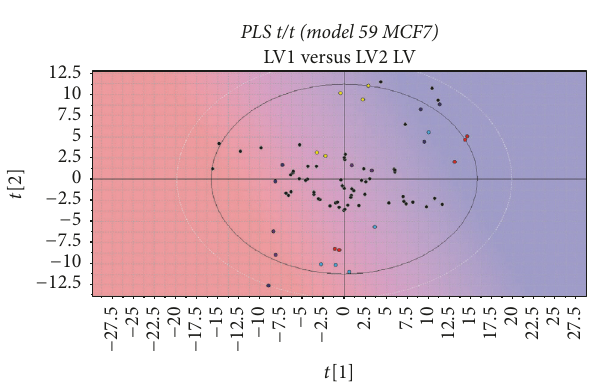
Figure 2: PLS 𝑡/𝑡 scores plot for 25 derivatives (yellow points) selected based on activity prediction: active, inactive, and moderately active.